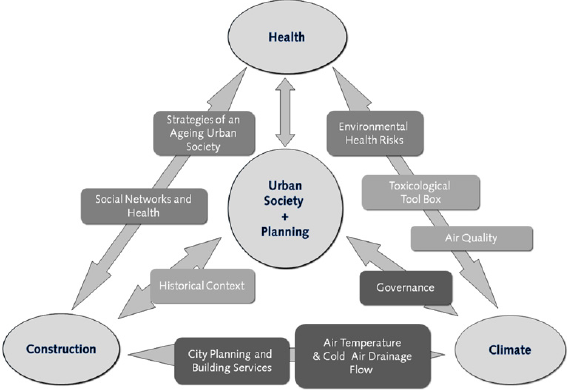
Figure 1. The structure of research project CITY 2020 + . The research was initially organized into three clusters, each including three